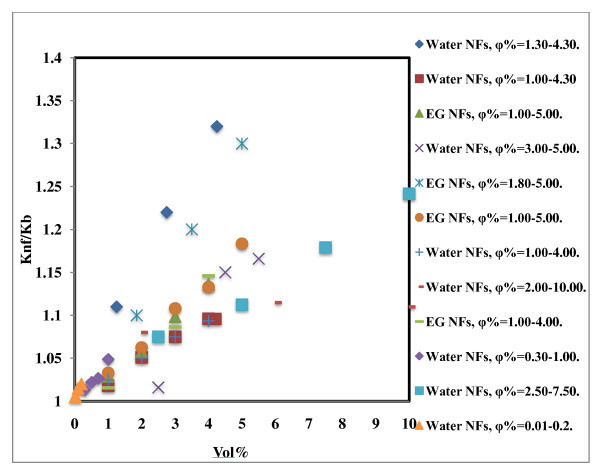
Effect of concentration on thermal conductivity of Al2O3-based nanofluids. Water NFs, φ% = 1.30-4.30 [15]; water NFs, φ% = 1.00-4.30 [1]; EG NFs, φ% = 1.00-5.00 [1]; water NFs, φ% = 3.00-5.00 [8]; EG NFs, φ% = 1.80-5.00 [16]; EG NFs, φ% = 1.00-5.00 [18]; water NFs, φ% = 1.00-4.00 [7]; water NFs, φ% = 2.00-10.00 [13]; EG NFs, φ% = 1.00-4.00 [11]; water NFs, φ% = 0.30-1.00 [17]; water NFs, φ% = 2.50-7.50 [14]; water NFs, φ% = 0.01-0.20 [19].